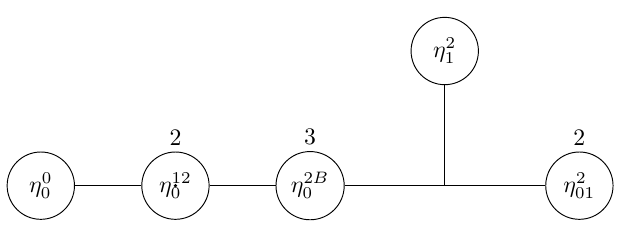
\ T , Resolution IV. This (cid:12)ber is 2 -model at S